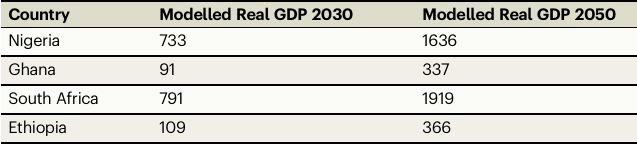
The price of phosphate was compared to current and published projected real GDP for fi ve countries (Nigeria, South Africa, Kenya, Ghana and Ethiopia; Table 2). The published data shown were pro- jected using a model based on the Cobb-Douglas function 51 . Table 2 | Projected Real GDP (US $) for different nations studied 51